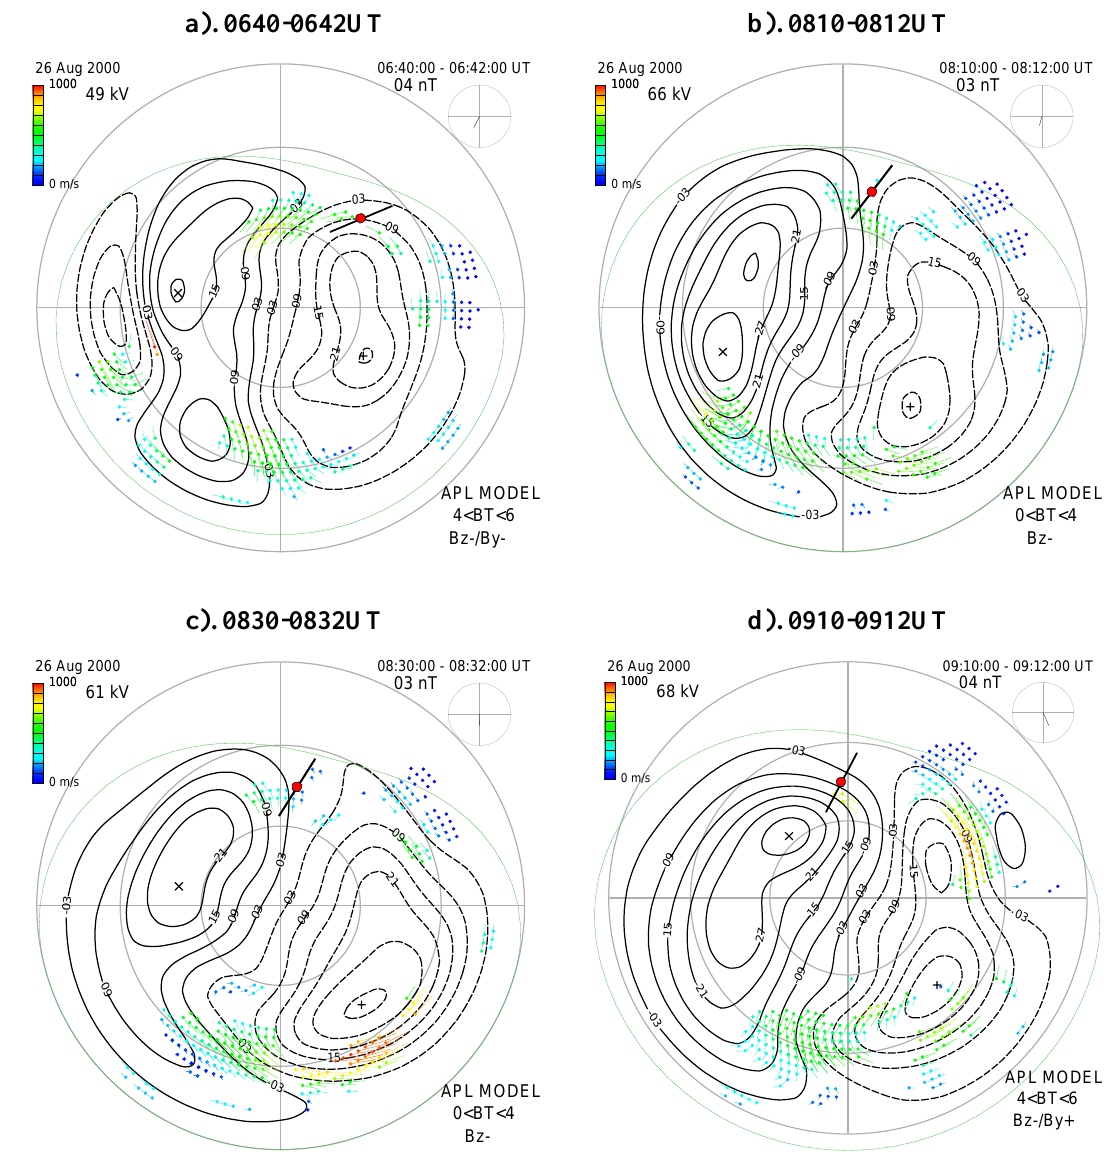
Fig. 6. Selected electric potential maps derived from line-of-sight velocity measurements from the SuperDARN HF radars broadly between 06:30–09:30 UT on 26 August